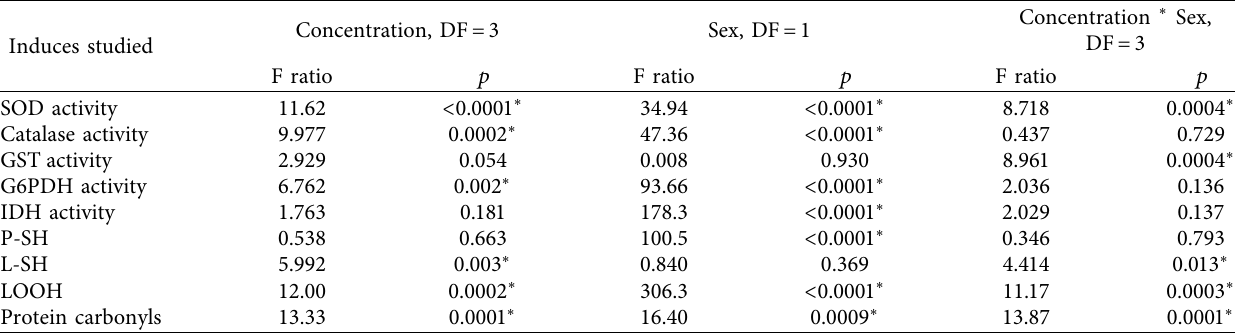
Concentration ∗ Sex,